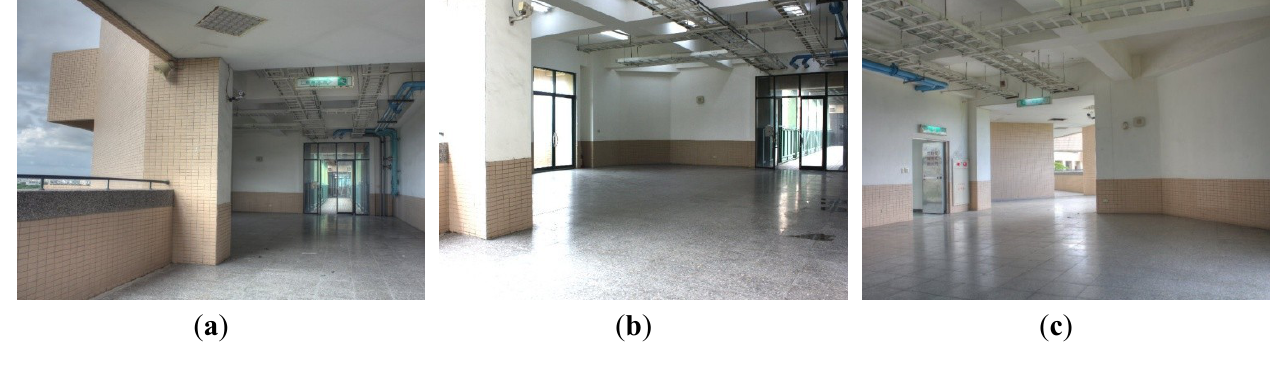
Figure 7. The corridor selected to evaluate the proposed method.